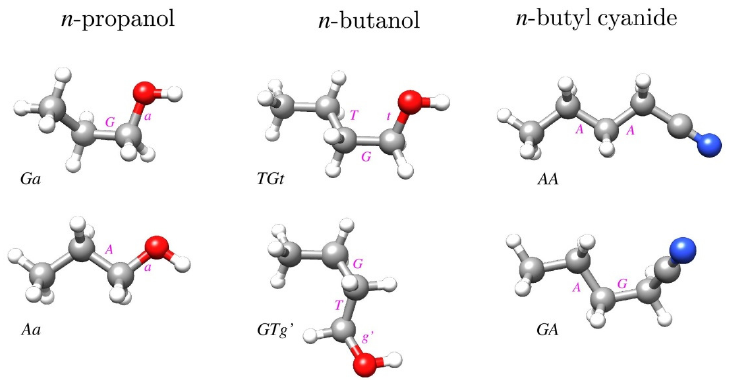
Figure 1. Geometries of two conformers of each of the three molecules studied in this work. The most stable conformer for each molecule is in the top row and conformer names are consistent with those used in the most recent rotational spectroscopy studies of these molecules [15–17]. The makeup of the conformer names is denoted by the magenta letters placed next to the bonds defining a given torsional orientation, leading to the conformer name by reading from left to right (or top to bottom for GTg ’).